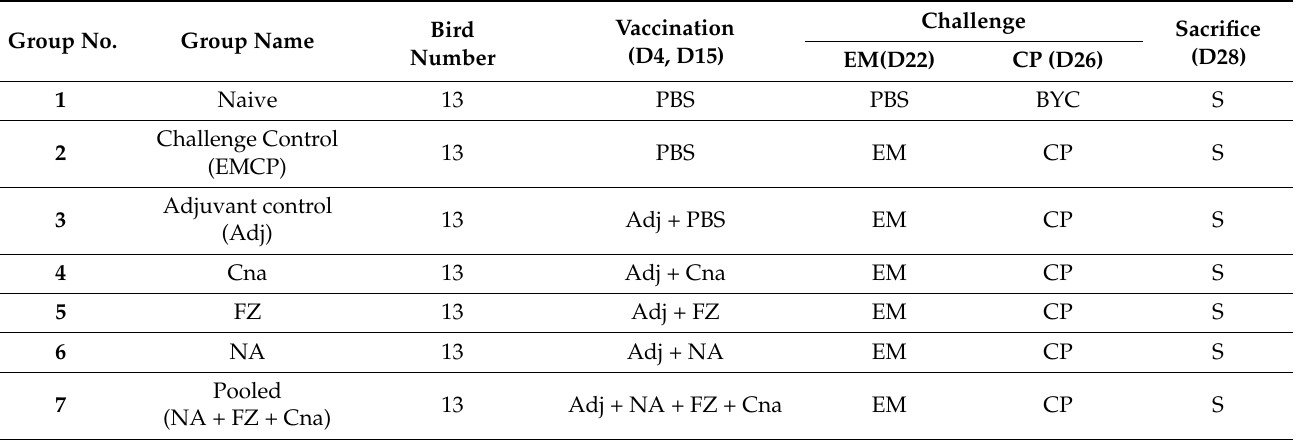
Table 1. Experimental design of vaccination studies